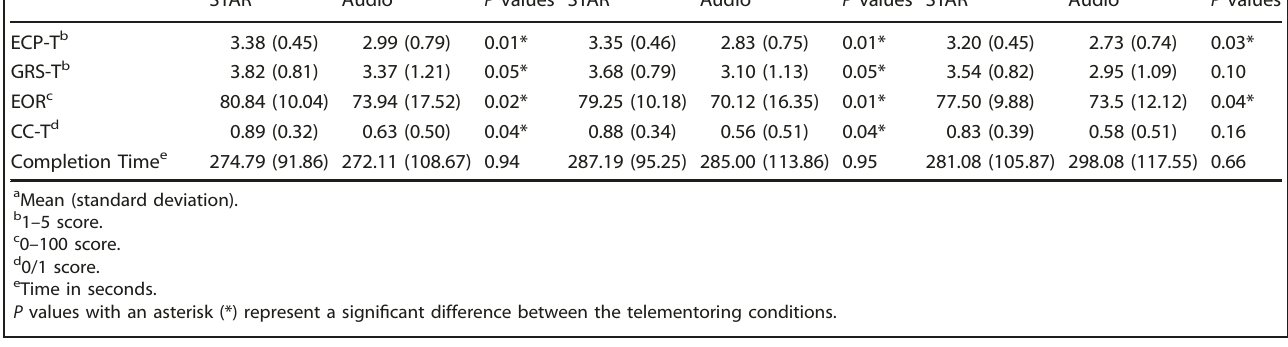
Table 1. Averaged results for the different comprehensive scores for the Overall Population and both the experience-based subgroups. Comprehensive score Overall Population n =